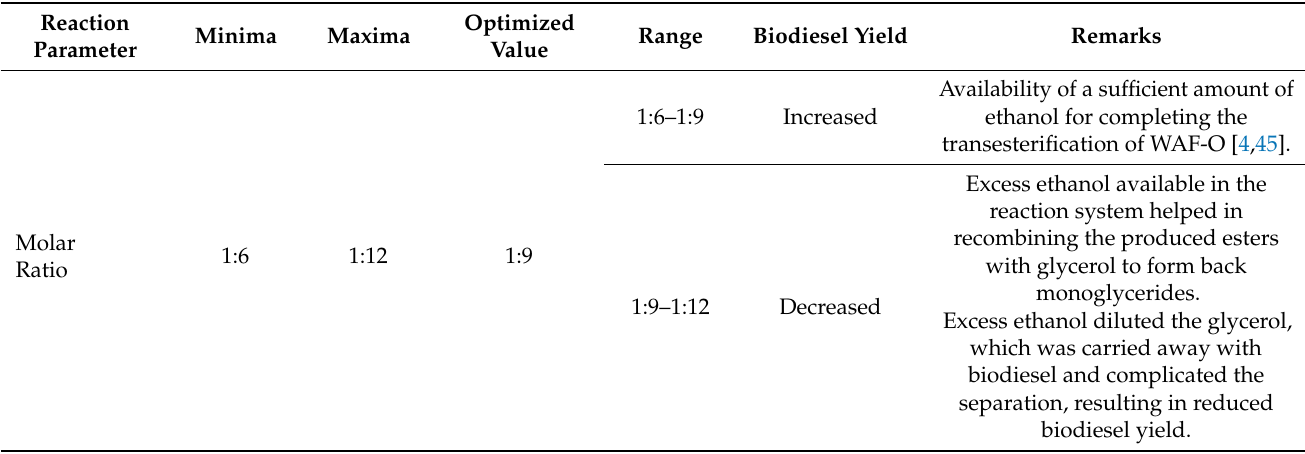
Figure 4. ( a ) Biodiesel yield for varying molar ratios; ( b ) biodiesel yield for varying catalyst con- centrations; ( c ) biodiesel yield for varying reaction temperatures; ( d ) biodiesel yield for varying reaction times. Table 2. Factors influencing the biodiesel yield for reaction parameters.